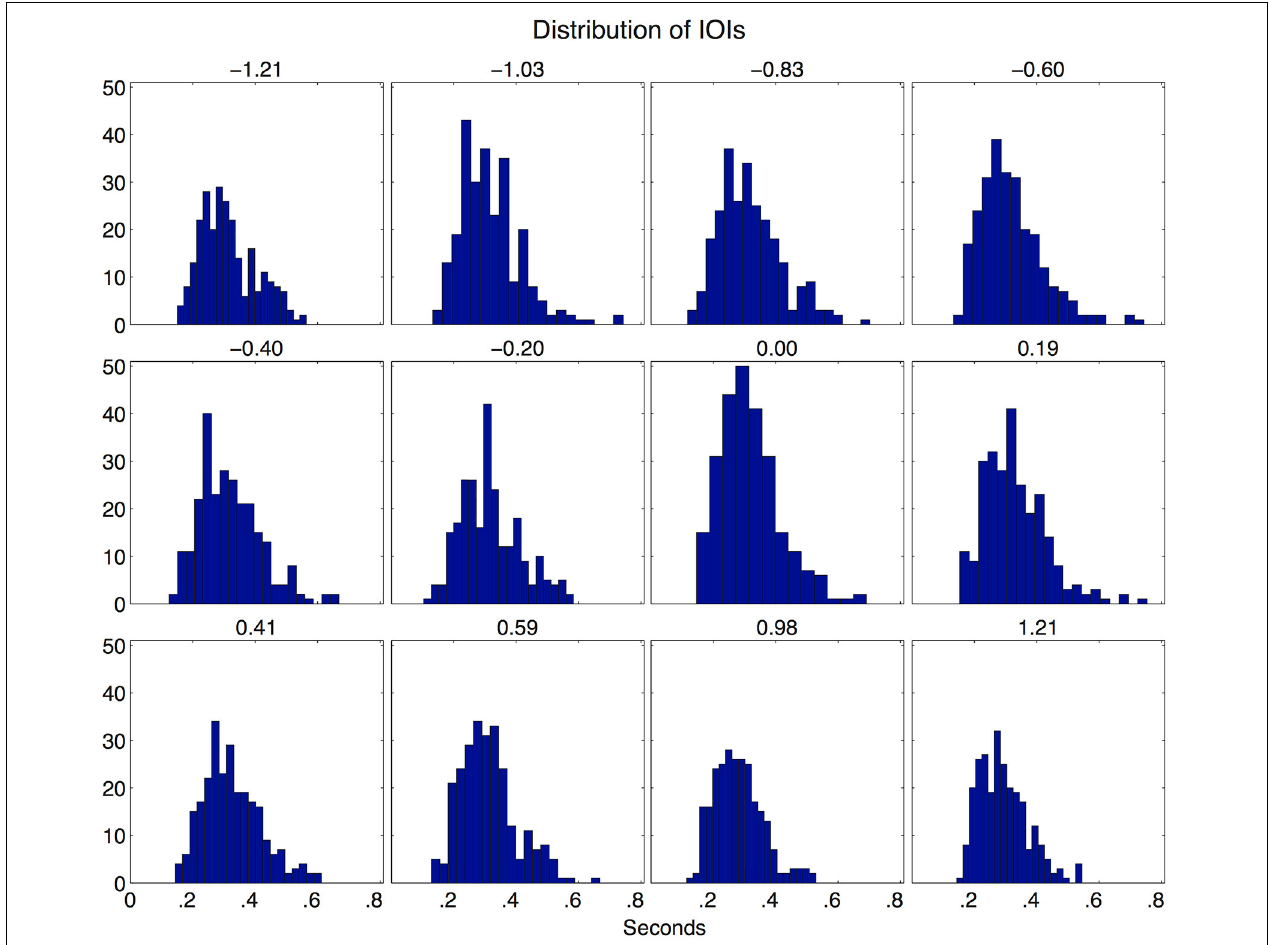
FIGURE 1 | The log-normal distribution for each non-isochronous stimulus is shown in a series of histograms.